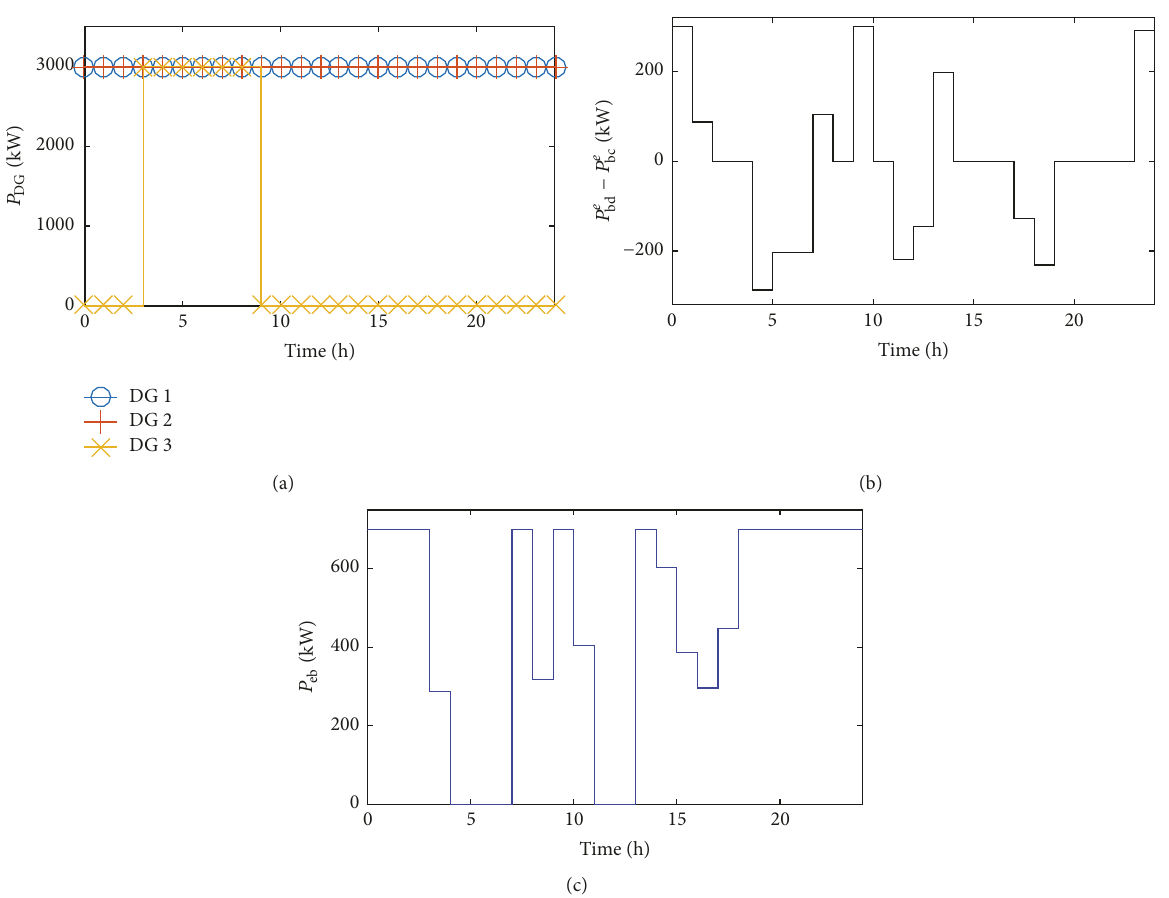
Figure 7: Scenario 5: (a) dispatch values of DG 1, DG 2, and DG 3, (b) BESS charge and discharge profiles, and (c) 𝑃 eb .